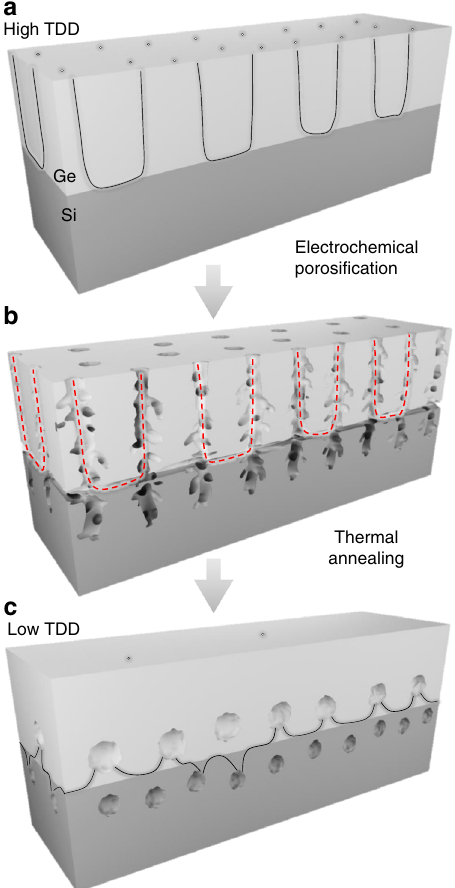
Fig. 1 Schematic illustration of the proposed approach. a Bulk Ge fi lm growth on (001) Si substrate. b Dislocation-selective electrochemical deep etching to form porous nanostructures from the bulk-grown Ge fi lm and the Ge/Si interface. The dotted line shows weakly branched pores that follow threading dislocation cores. c Thermal annealing of the nanoporous structure to transform it into nanovoids that attract dislocations, facilitating their subsequent annihilation. The resulting con fi guration is referred to as nanovoid-based Ge/Si virtual substrate